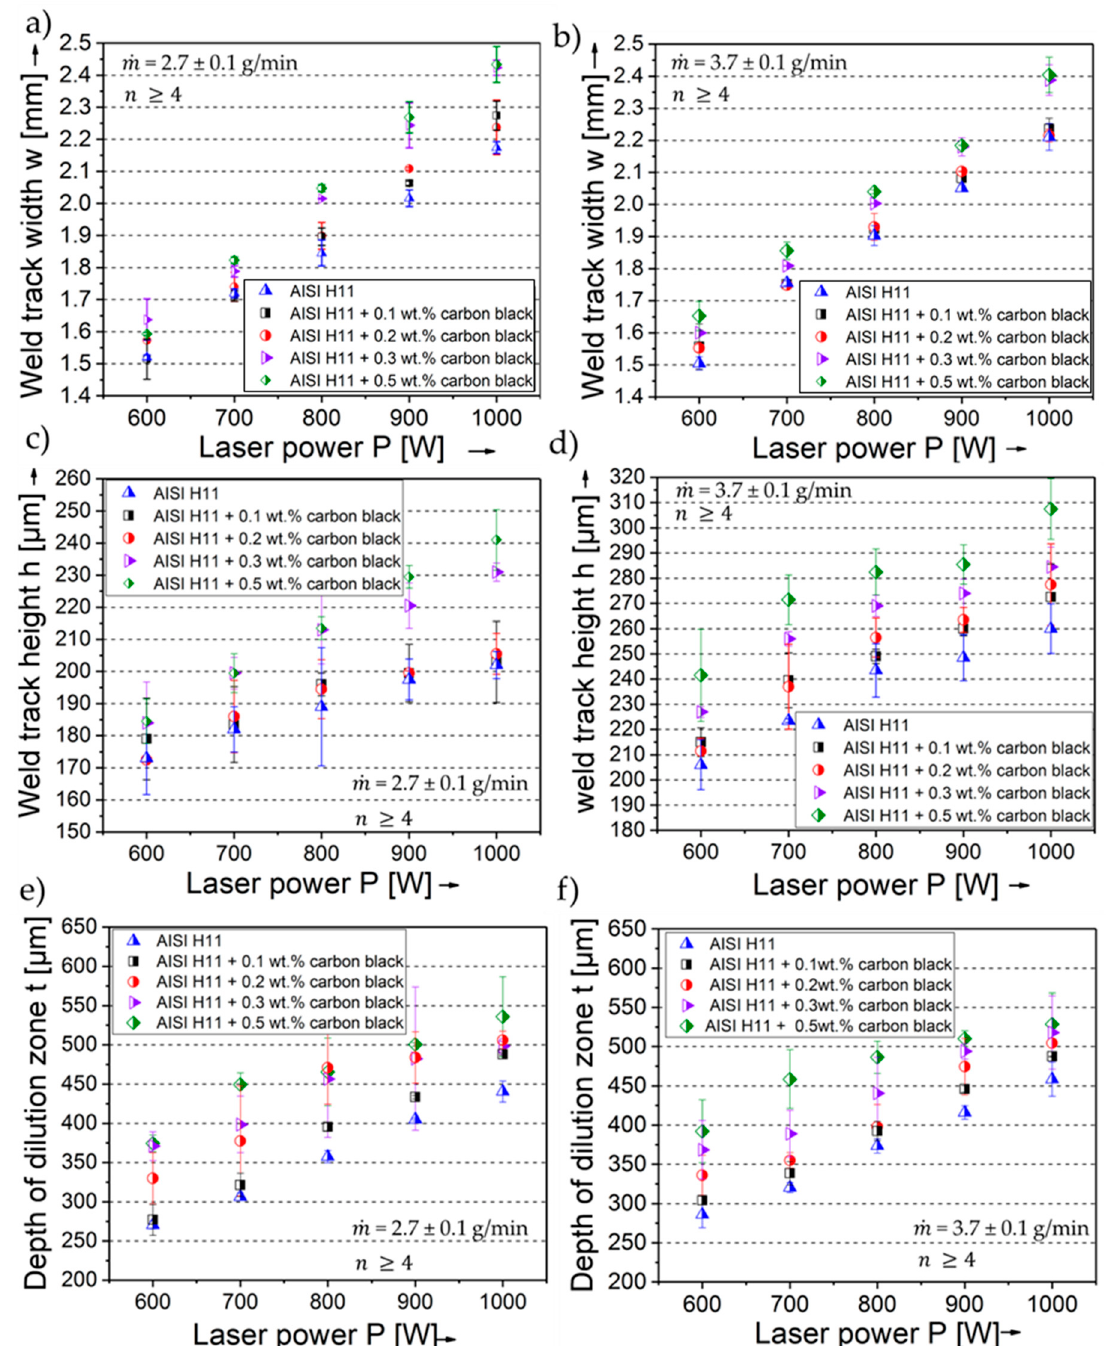
Figure 6. Weld track ( a , b ) width, ( c , d ) height and ( e , f ) depth of the dilution zone of single weld tracks as a function of laser power and for a powder mass flow of 2.7 ± 0.1 g/min and 3.7 ± 0.1 g/min.